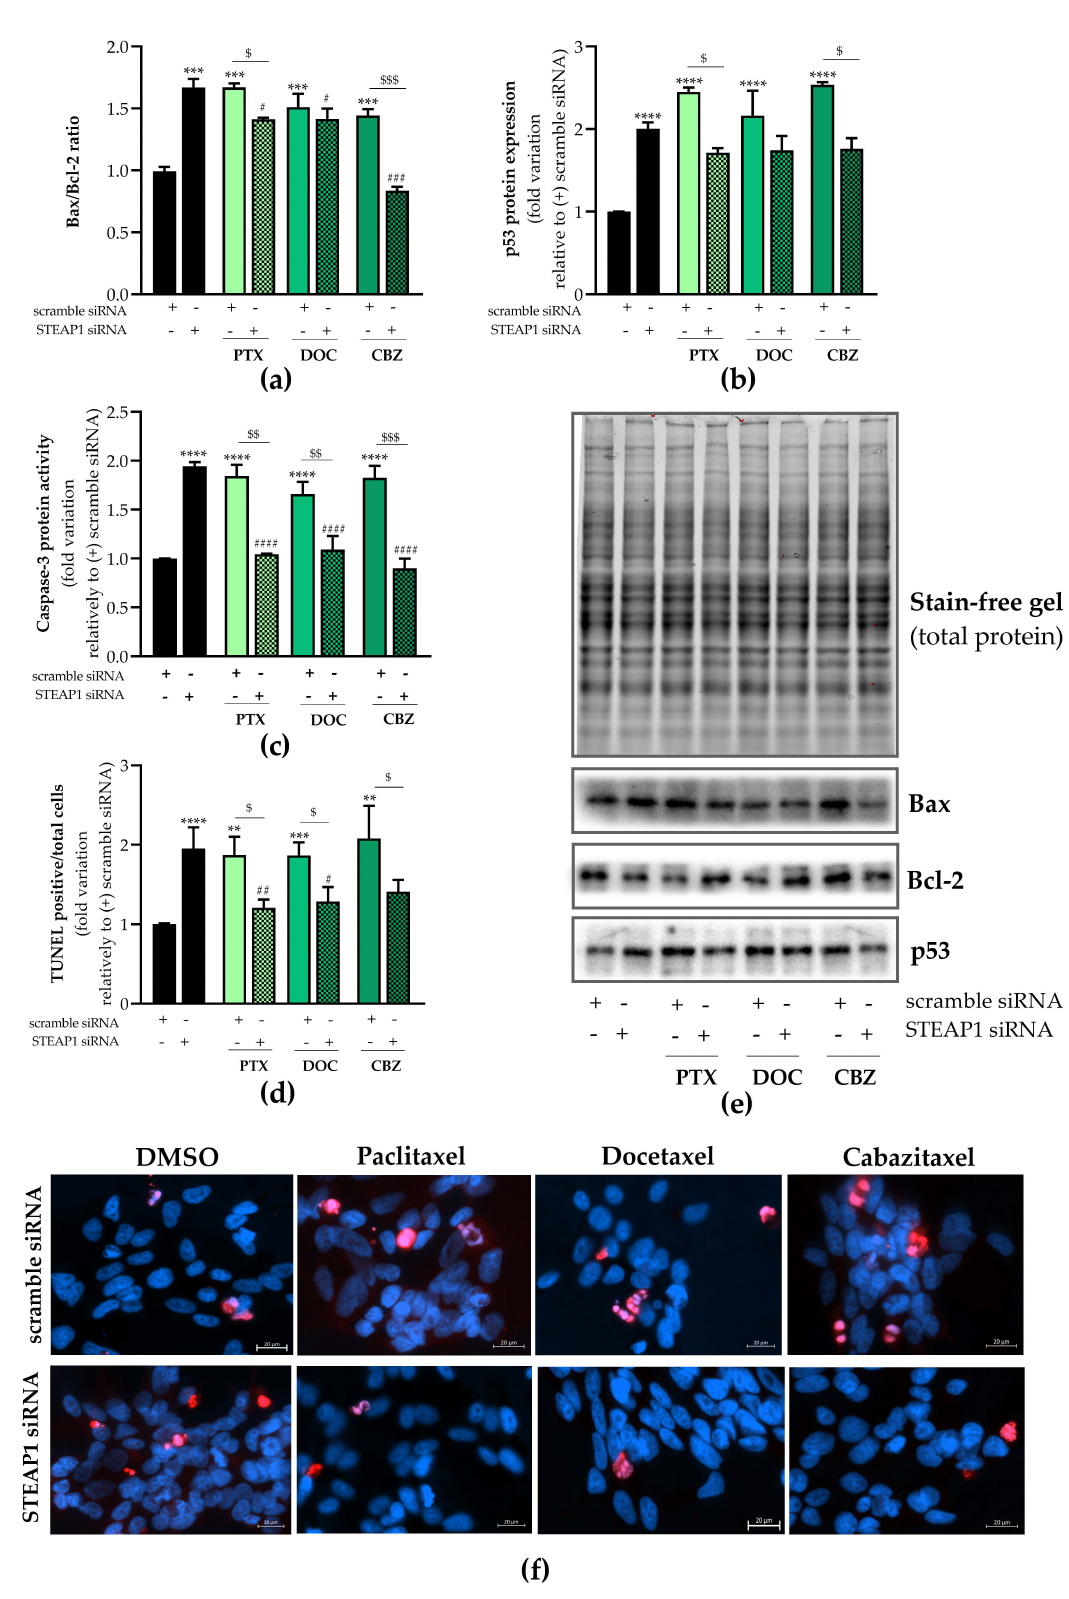
Figure 6. Effect STEAP1 knockdown and paclitaxel, docetaxel, or cabazitaxel on LNCaP cells apoptosis. Human neoplastic LNCaP prostate cells were transfected with scramble or STEAP1 small